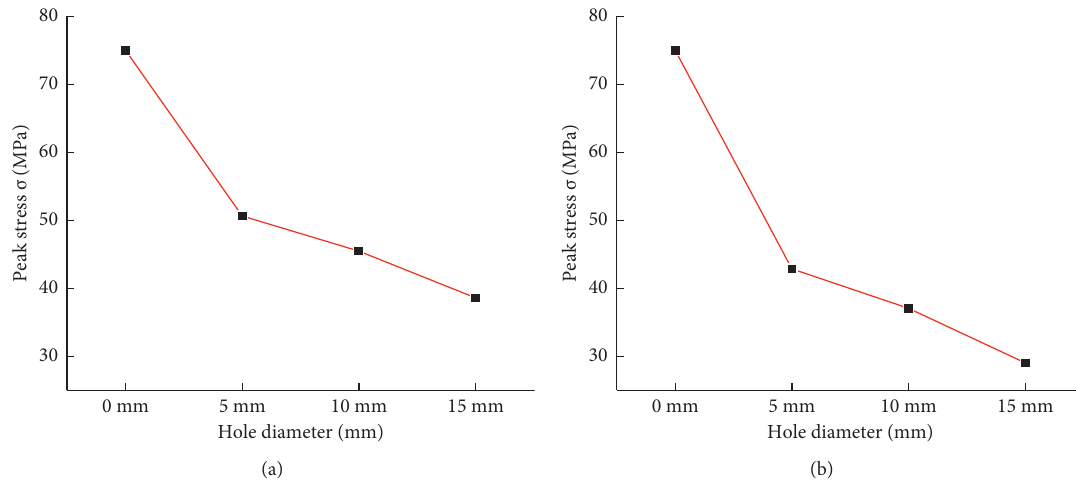
Figure 4: Peak stress on the rock with different diameters of the hole. (a) Peak stress on the rock with different diameters of the horizontal hole. (b) Peak stress on the rock with different diameters of the vertical hole.